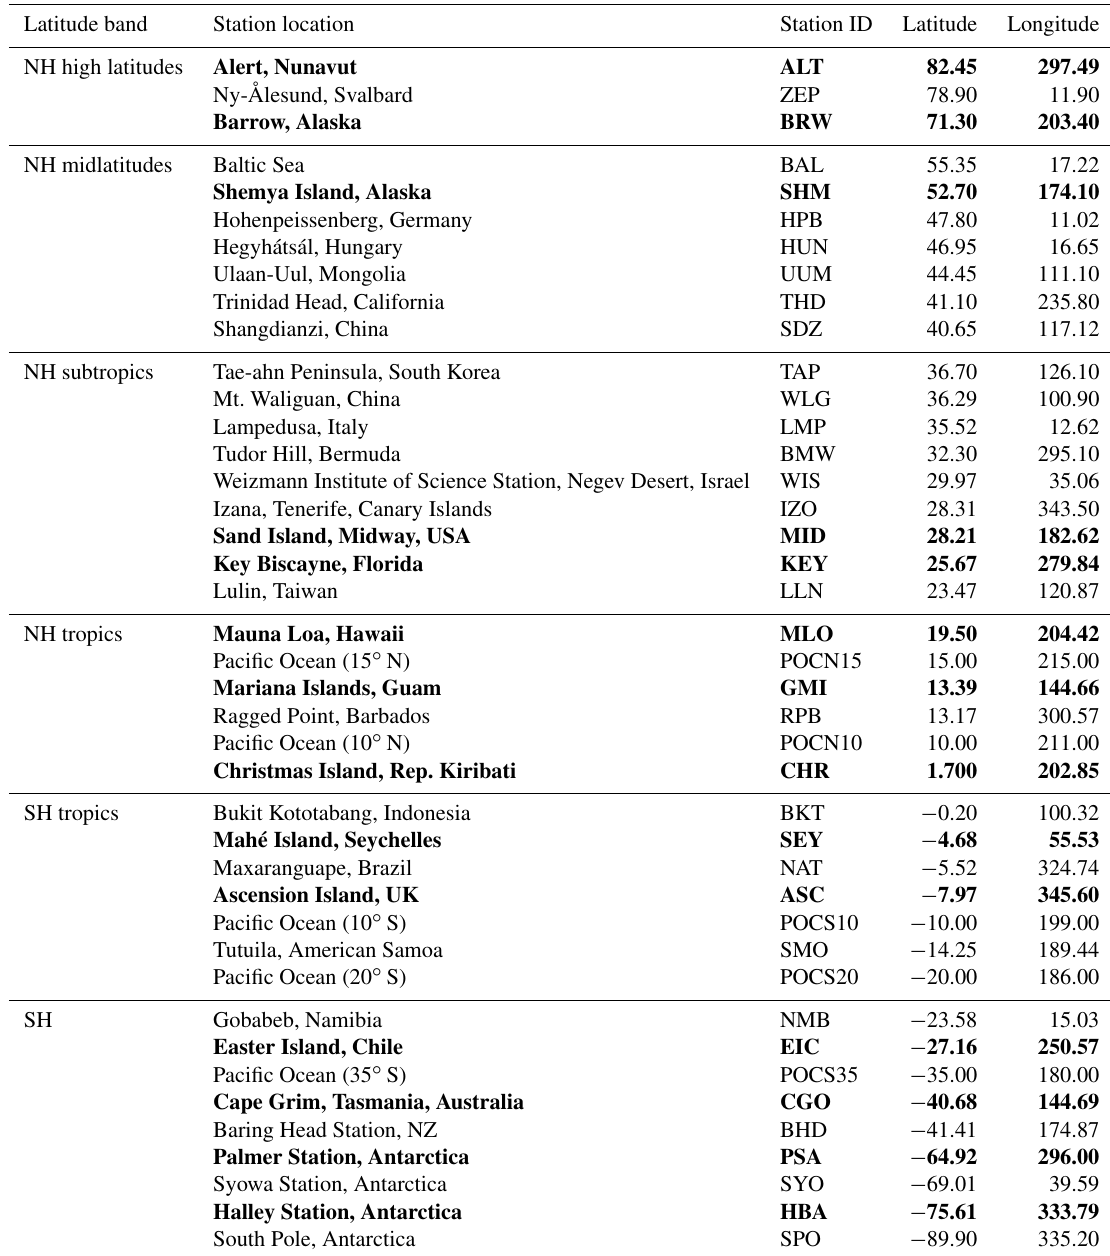
Table 1. Latitude band, station location, station ID, latitude, and longitude of CO 2 sample locations. Observations from bold stations were analyzed over the 1985–2013